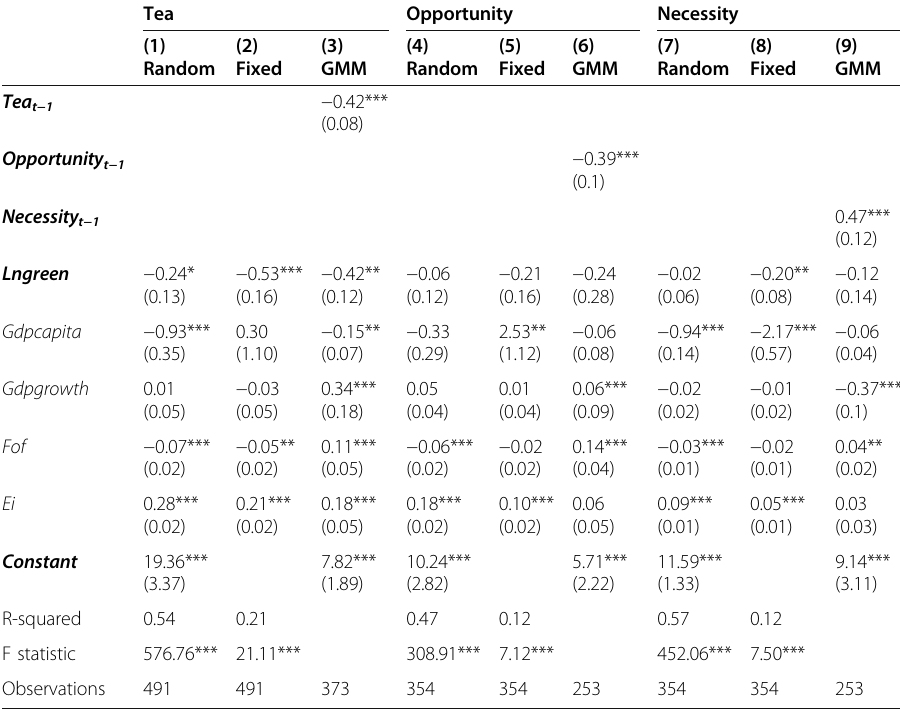
Table 6 Relationship between Greenfield investment and entrepreneurship after-crisis period